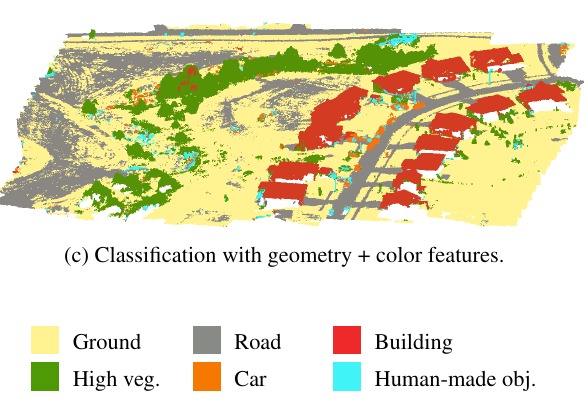
Figure 4. Qualitative results obtained with our approach on the Buildings dataset, using the other two datasets for training. We used neighbor color features within a 0.6-meter radius neighbor- hood and the Gradient Boosted Trees classifier. Incorporating color information into the classifier results improves classifica- tion, particularly for the roads between buildings. Testing dataset Ankeny Building Cadastre Geom. features